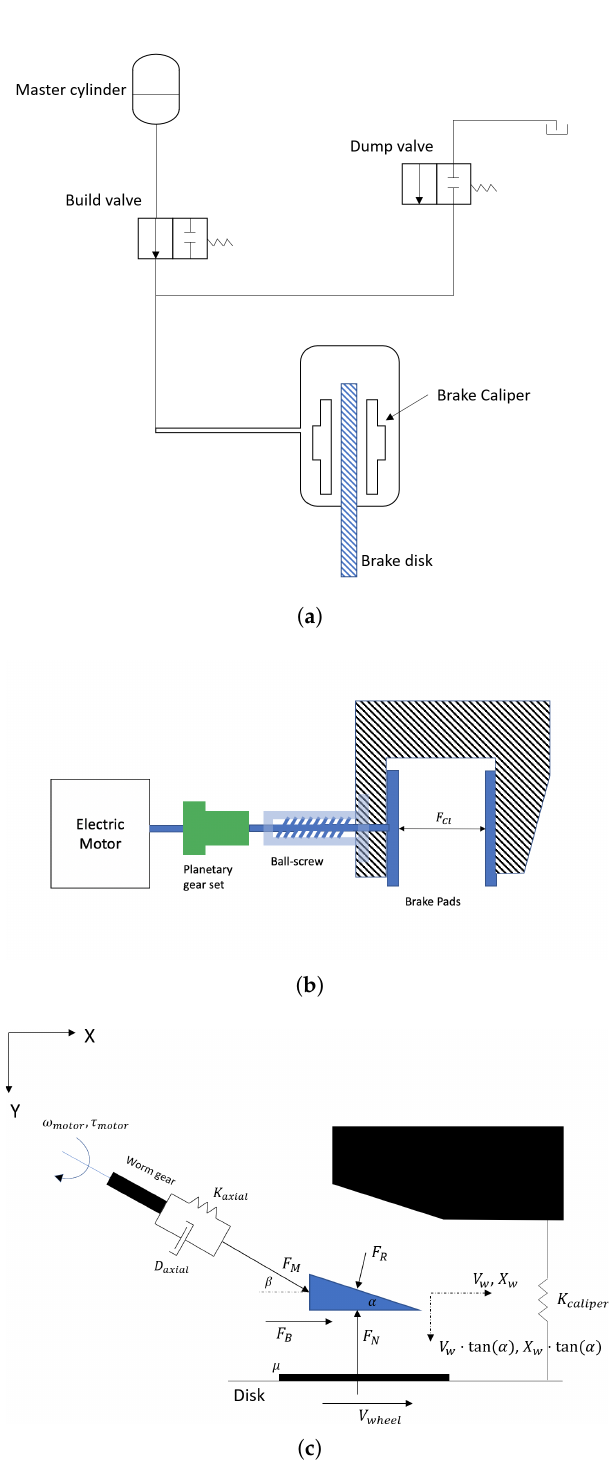
Figure 1. Schematics of brake-by-wire actuators. ( a ) Electro-Hydraulic Brake [33]; ( b ) Electro- Mechanical Brake; ( c ) Electronic Wedge Brake